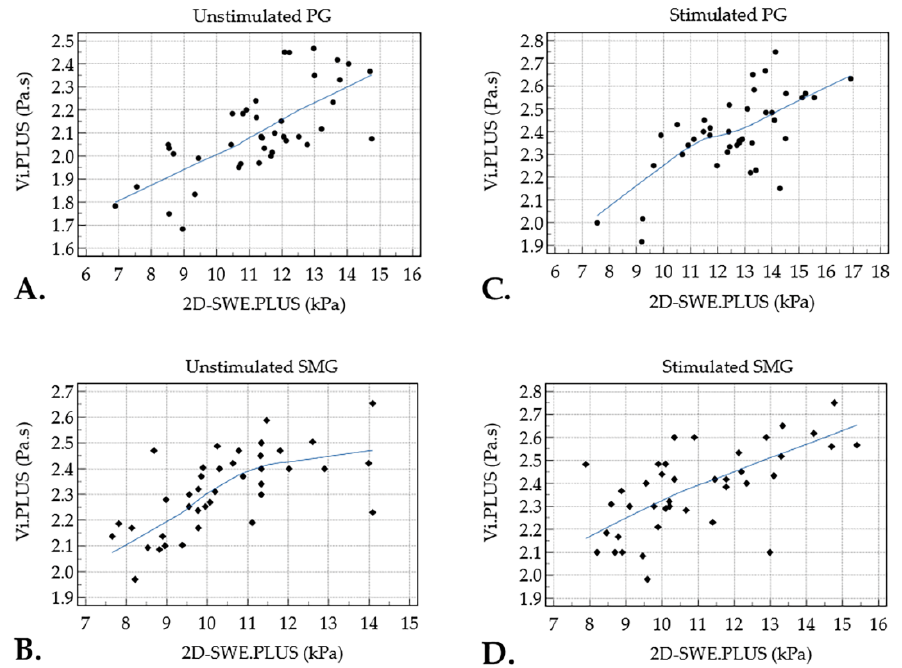
Figure 3. Relationship between the mean values assessed by Vi.PLUS and 2D-SWE.PLUS of parotid glands (PG) and submandibular glands (SMG) before ( A , B ) and after stimulation ( C , D ) with citric acid in healthy subjects (blue line—trend line).